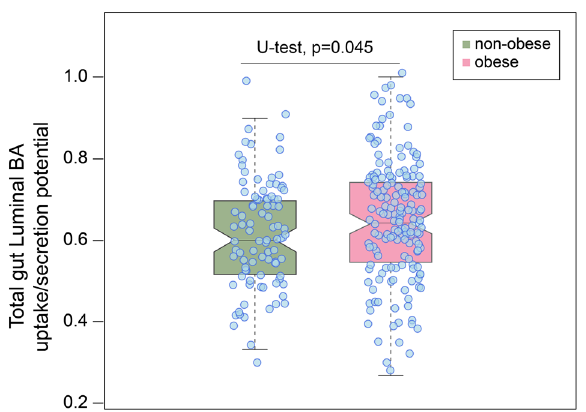
Figure 6. Modeling of the intestinal luminal bile acids uptake/secretion potentials in non-obese and obese individuals. Box plot showing a significant difference in the total luminal bile acid potentials for bile acid uptake/secretion between non-obese (n = 106) and obese (n = 177) subjects as evaluated by Mann–Whitney U test. The statistical significance is given by ( P <